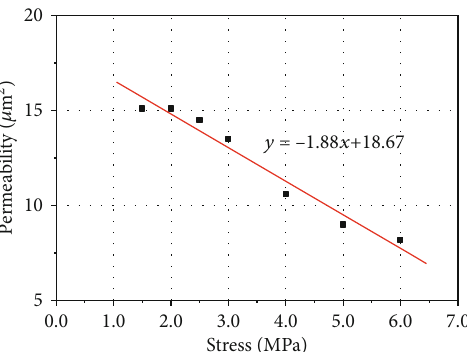
Figure 13: Permeability scatter diagram of rock specimen 3.